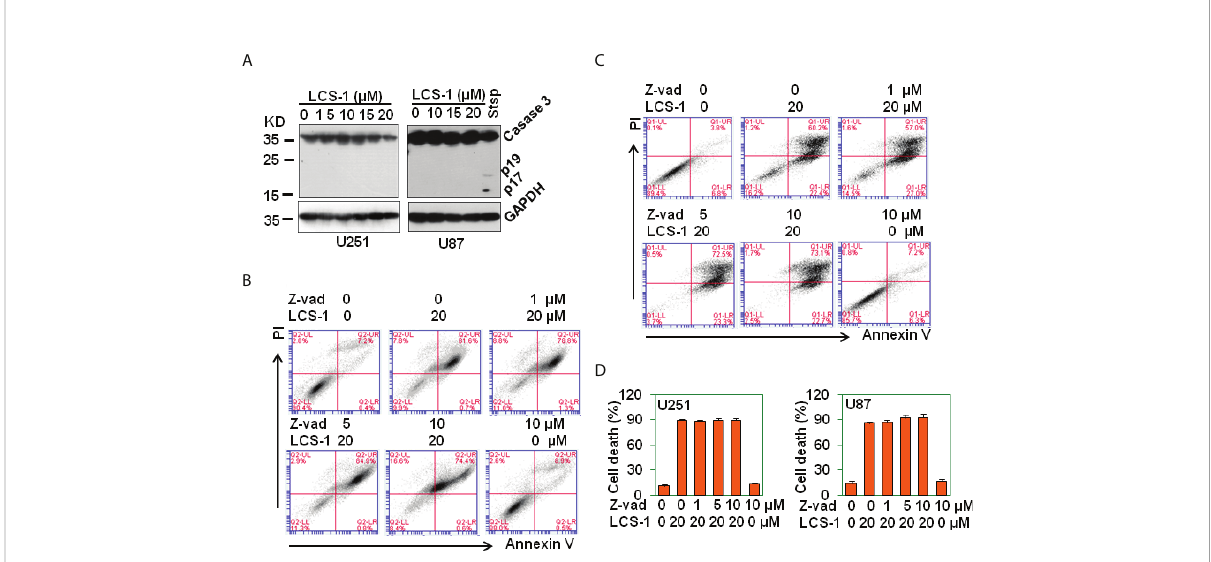
FIGURE 8 LCS-1-induced cell death is Caspase in-dependent. (A) Western blot analysis of caspase 3 activation in U251 and U87 cells treated with the indicated doses of LCS-1 for 24 h. U87 cells treated with 1 m M Staurosporine (Stsp) for 24 h as positive controls. GAPDH protein levels were measured as loading controls. (B) PI/FITC-Annexin V staining of death of U251 glioma cells pretreated with the indicated doses of pan-caspase inhibitor Z-vad-FMK (Z-vad) for 1 h, and retreated with 20 m M LCS-1 for 24 h (C) PI/FITC-Annexin V staining of death of U87 glioma cells pretreated with the indicated doses of pan-caspase inhibitor Z-vad-FMK (Z-vad) for 1 h. and retreated with 20 m M LCS-1 for 24 h (D) Quantitative data from B and C